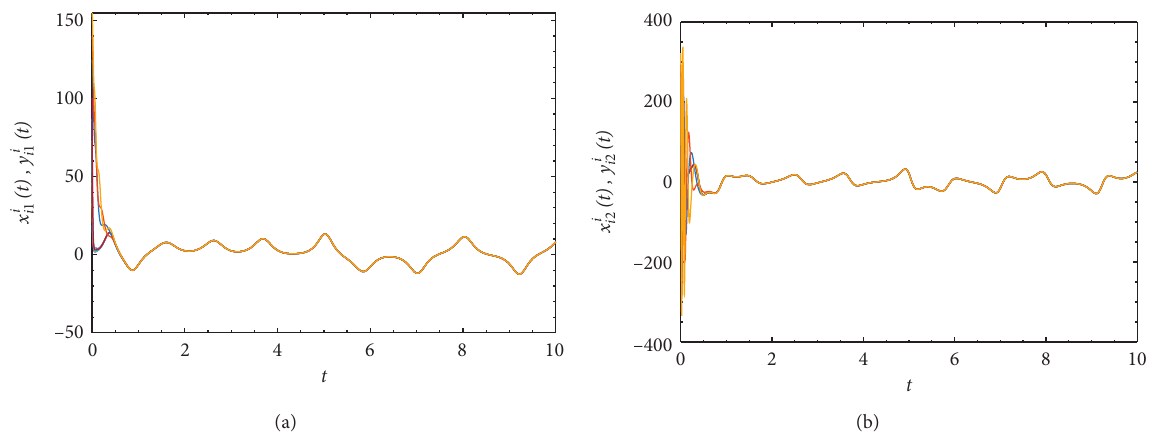
Figure 4: The evolution of x